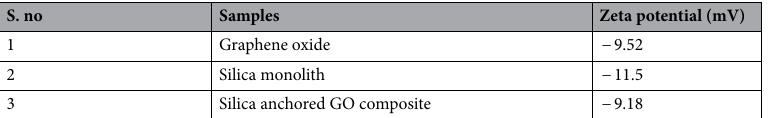
Table 2. Zeta potential of graphene oxide, silica monolith, and silica anchored graphene oxide composite.